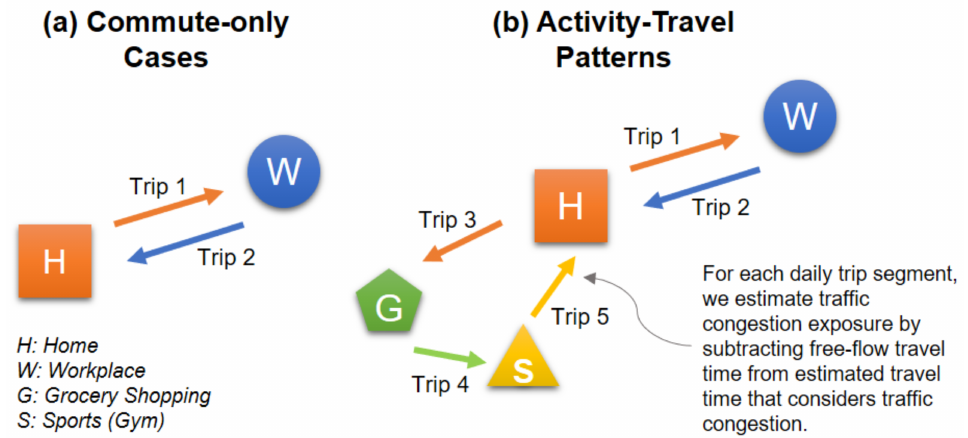
Figure 2. An example of estimating an individual’s exposure to traffic congestion for two types of assessments: ( a ) commute-only versus ( b ) activity-travel patterns in addition to commuting